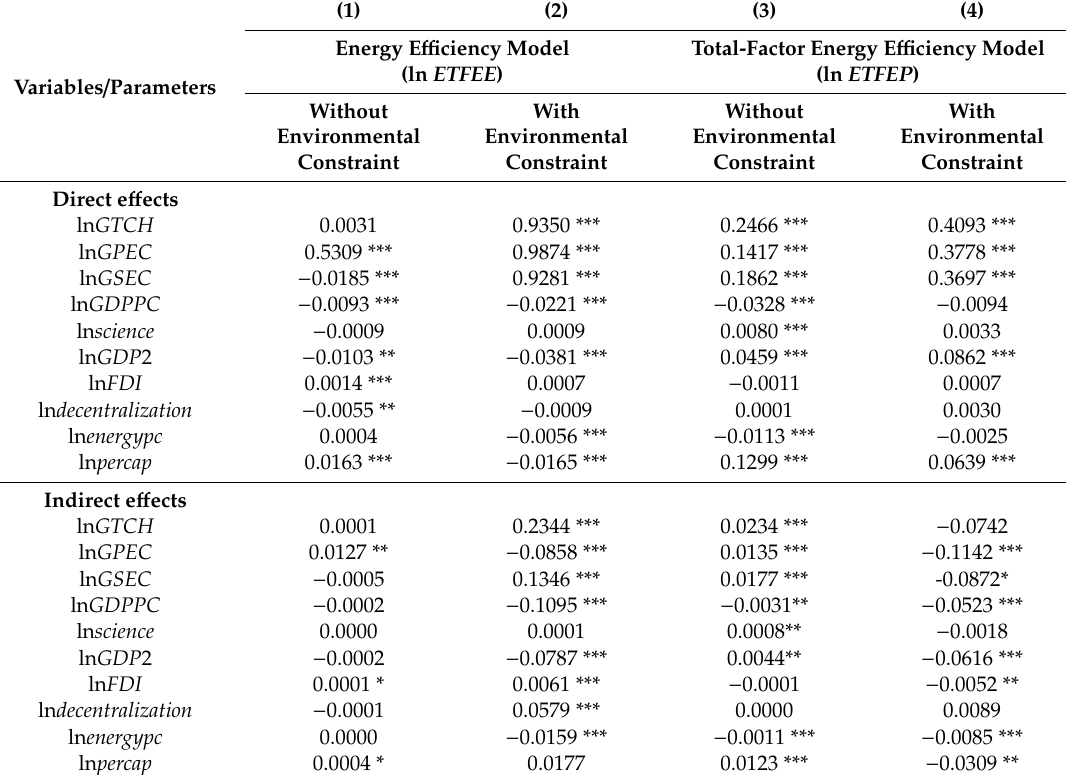
Table 5. Direct, indirect and total e ff